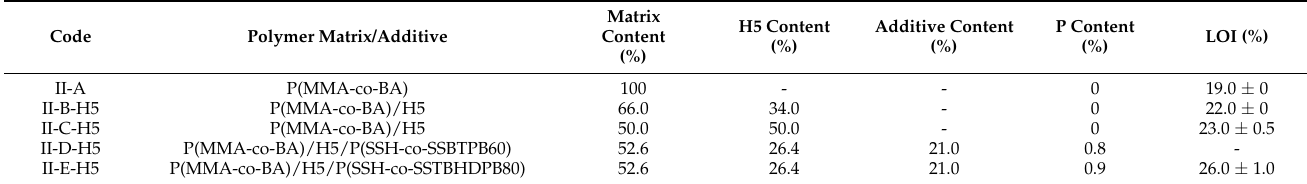
Table 6. LOI measurements of P(MMA-co-BA) blends with H5 and additives.